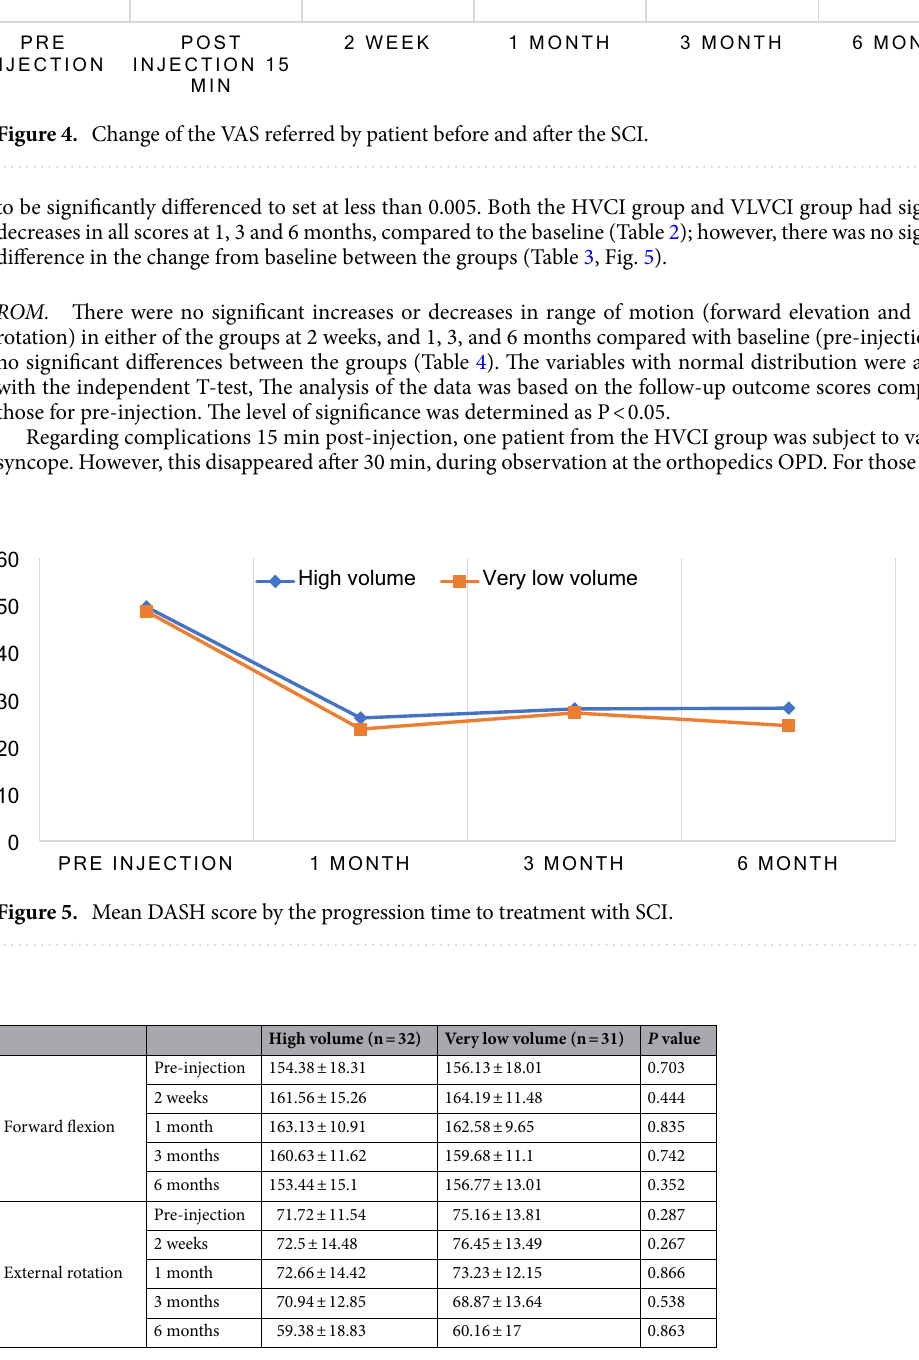
Table 4. Range of motion at pre-injection times, 2 weeks and 1-, 3- and 6-months